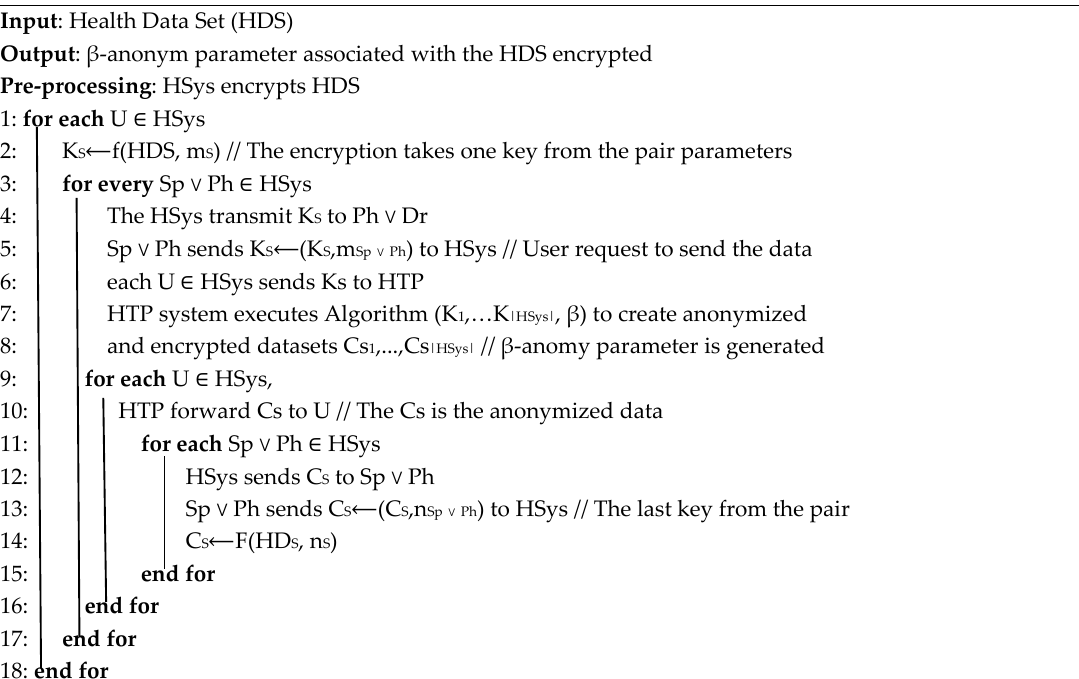
Algorithm 1: Overall Algorithm (Tripartite: < User, HSys and HTP > )